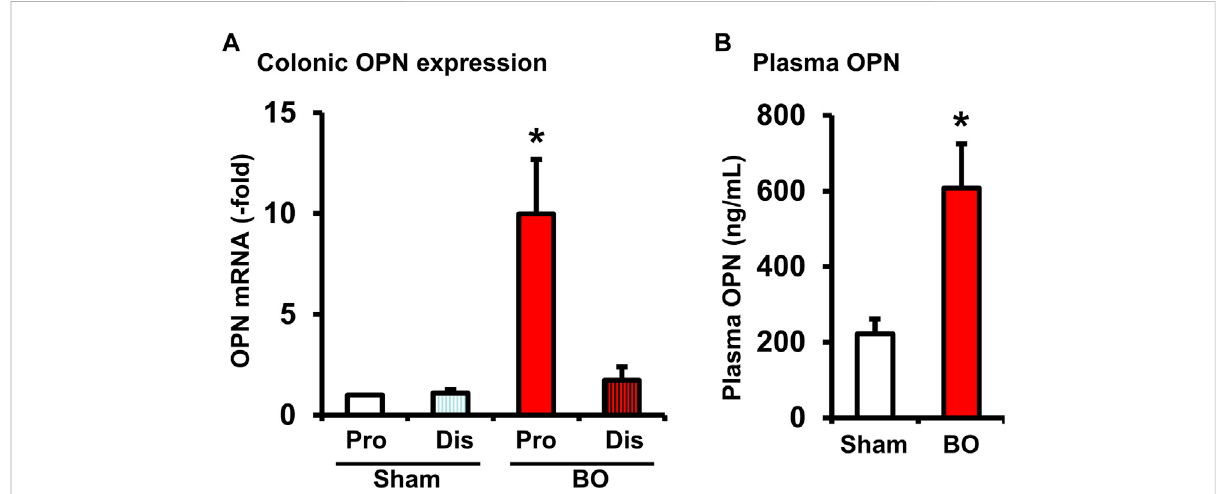
FIGURE 7 Osteopontin expression in the colon (A) and plasma OPN levels (B) during bowel obstruction. Rats with sham operation and bowel obstruction (BO) for 7 days were euthanized for collections of colon tissues and blood. The muscularis externa tissues of the colonic segments 2 cm proximal (Pro) and 1 cm distal (Dis) to the site of obstruction band were taken for real-time qPCR study. Left ventricle blood was taken for preparation of plasma samples and EIA measurements of OPN. N = 5 or 6. * p ≤ 0.05 vs. Sham.